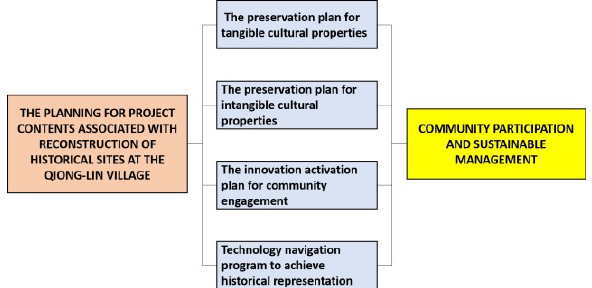
Figure 2. The architecture diagram of this